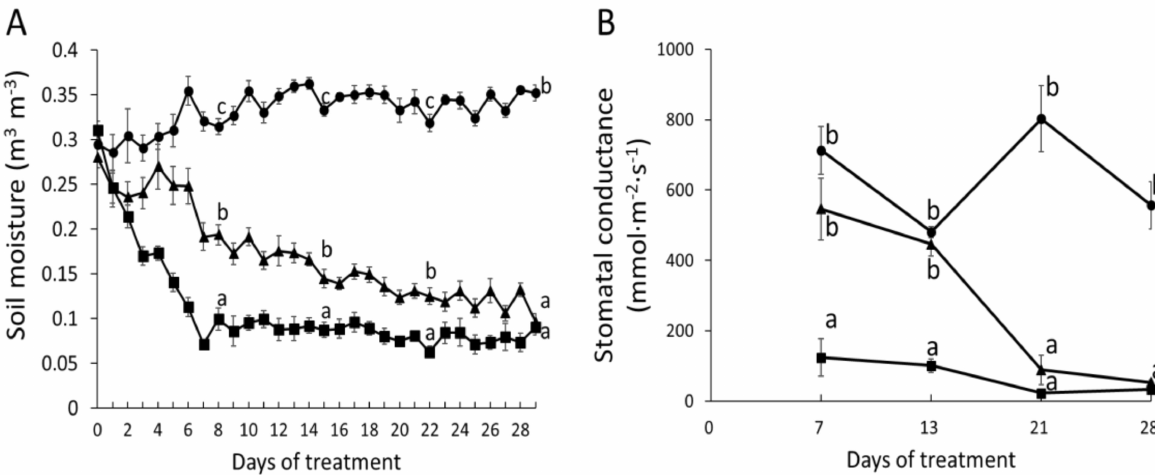
Figure 1. Soil moisture in pots ( A ) and stomatal conductance of poplar (hybrid T89) ( B ) in response to moderate (triangles) and severe (squares) drought stress and well-watered (circles) conditions. ( A ) Soil moisture in pots of plants in response to drought. Data show means ± SE ( n = 8). One-way ANOVA was conducted with the data measured on 8th, 15th, 22nd, and 29th day of the treatment. Tukey-test was applied post-hoc and means that differ at p ≤ 0.05 are indicated by different letters. ( B ) Stomatal conductance of plants in response drought. Data show means ± SE ( n = 8) measured on 7th, 13th, 21th, and 28th day of the treatment. One-way ANOVA was conducted for each day. Tukey-test was applied post-hoc and means that differ at p ≤ 0.05 are indicated by different letters.